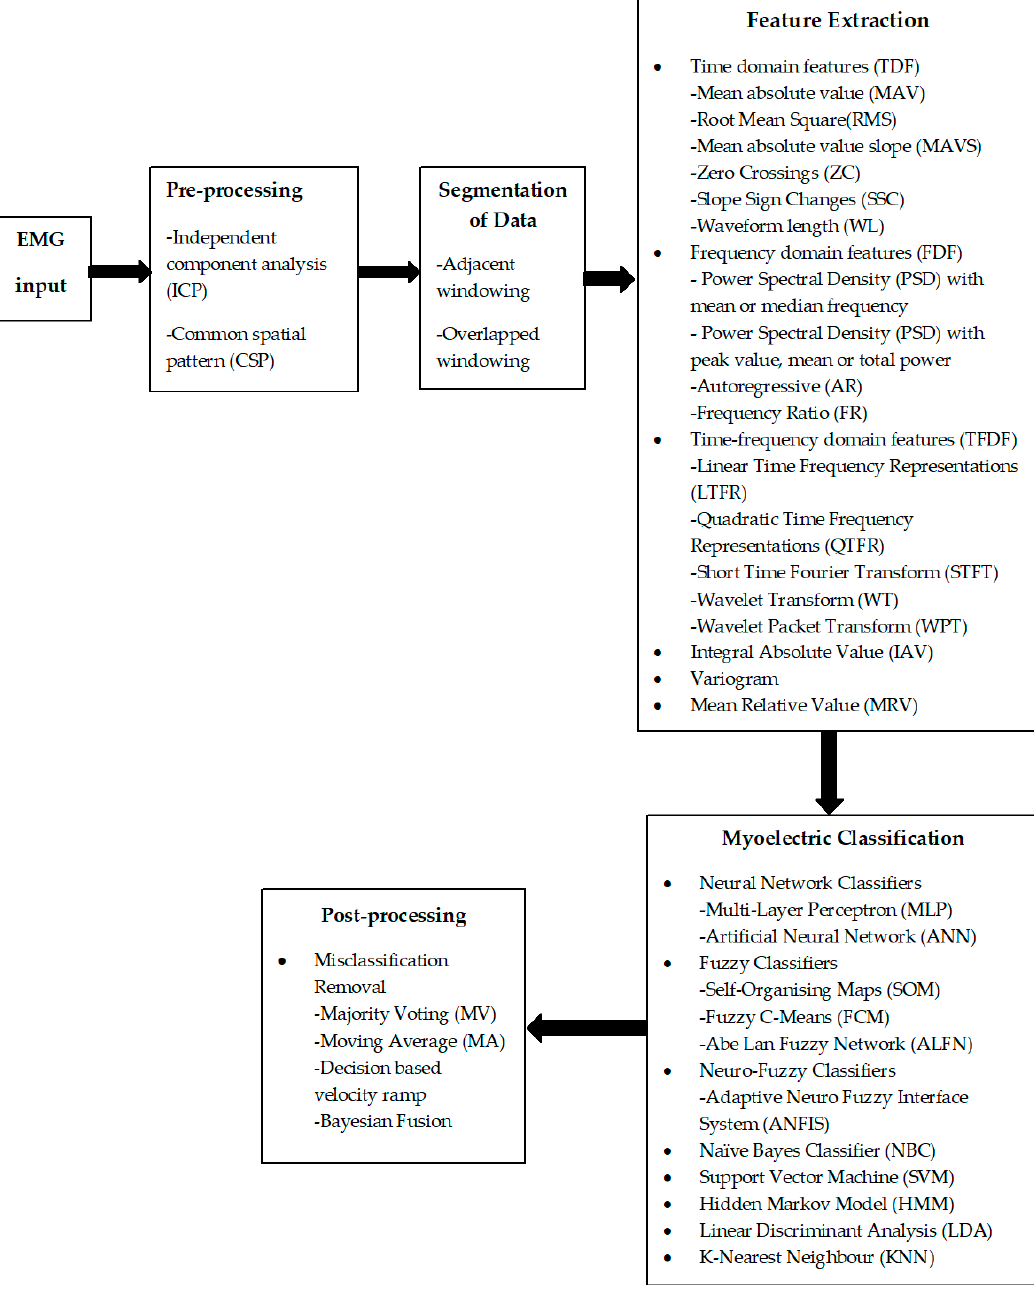
Figure 1. General pattern recognition schemes [11,26,27]. EMG: electromyography.